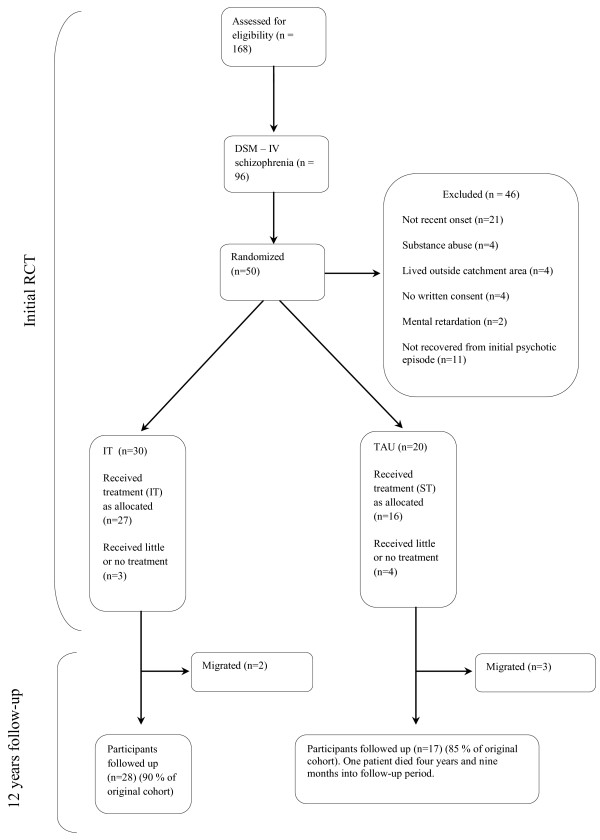
Participant flow.